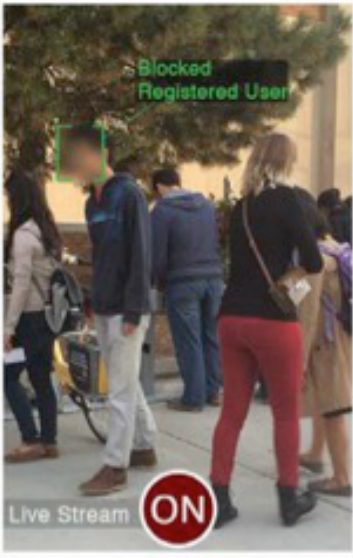
Figure 3. Passerby face is blurred thanks to nonrecording database or toggle setting.